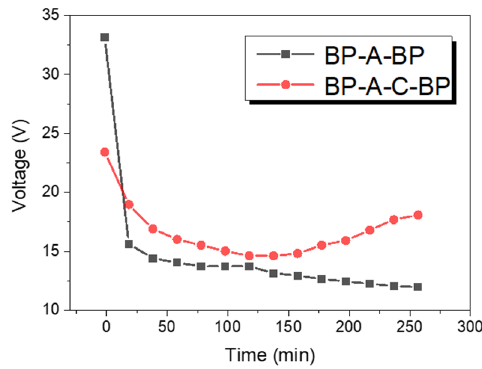
Figure 9. The voltage drop across the stack in di ff erent